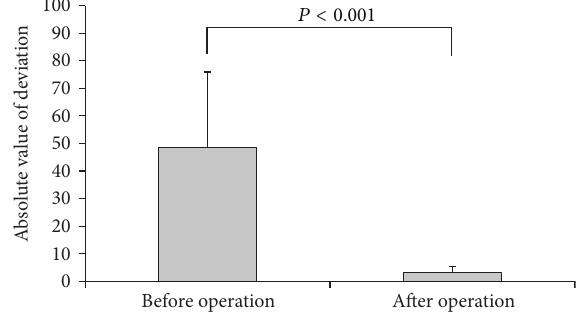
Figure 3: Comparison of the angle of strabismus while looking at far objects (6 m) before APRMT and at the 6-month follow-up. Data are represented as mean with SD for the absolute values of deviations before and after operation. The absolute values before and after deviations were compared using paired t -test. 𝑃 < 0.001 indicates significantly different between before and after deviations.